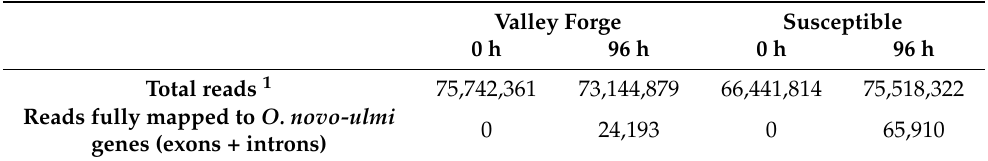
Table 1. Overview of RNA-Seq data for Ulmus americana - Ophiostoma novo-ulmi ssp. ameri- cana